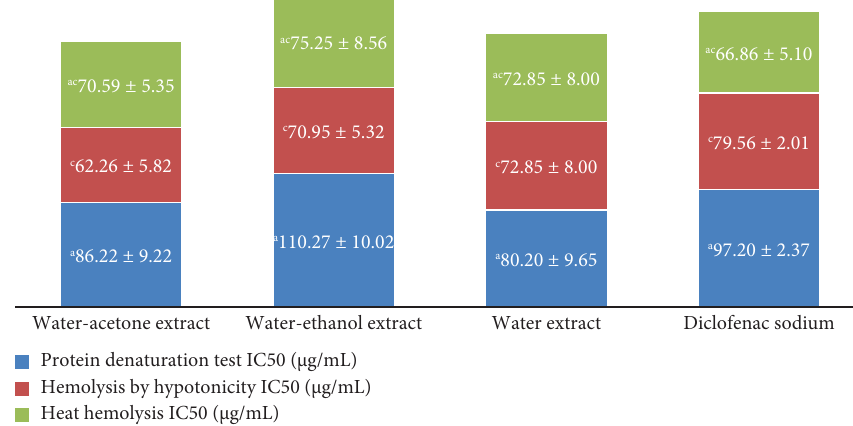
Figure 4: Anti-infammatory activity of Antrocaryon klaineanum .